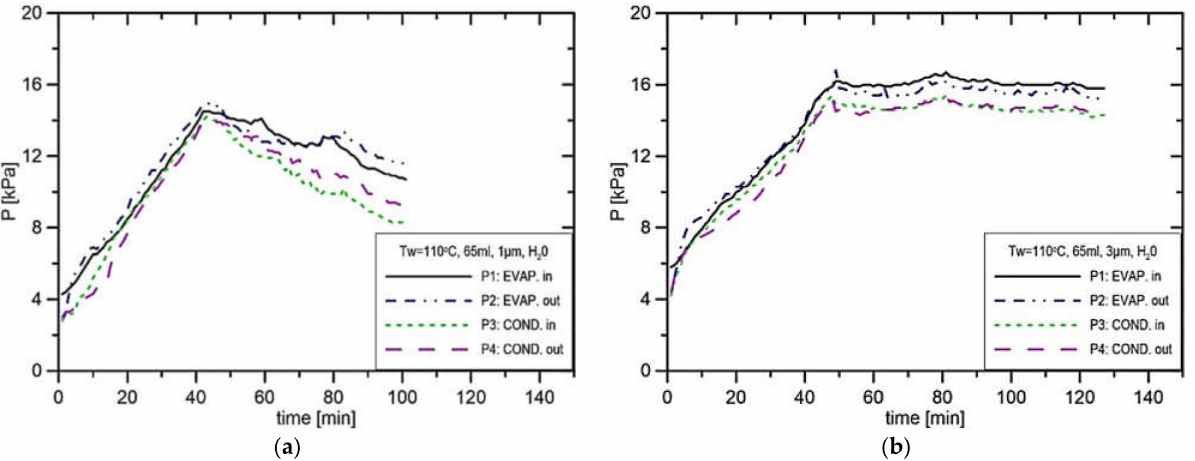
Figure 12. Distribution of pressure in function of time in case of water, charge volume 65 mL, T w = 110 ◦ C, ( a ) R p = 1 µ m, (b ) R p = 3 µ